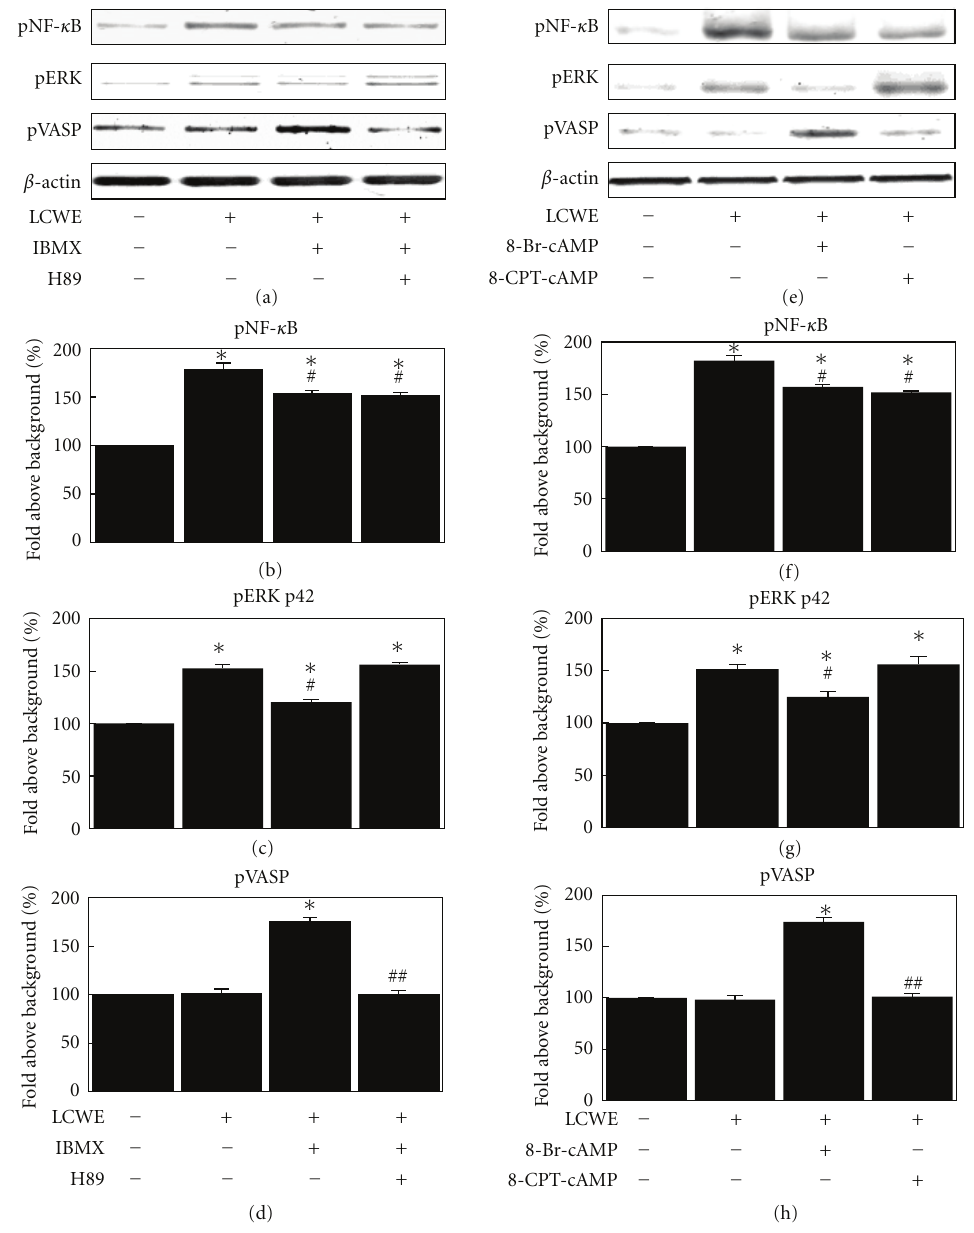
Figure 5: Change in the levels of phospho-NF- κ B (a, b), phospho-ERK (a, c), and phospho-VASP (a, d) in NIH3T3 mouse fibroblast cells after treatment with LCWE (10 μ g/mL), a combination of IBMX (1 μ M) and LCWE (10 μ g/mL), or a combination of IBMX (1 μ M), LCWE (10 μ g/mL), and H89 (5 μ M). Change in the levels of phospho-NF- κ B (e, f), phospho-ERK (e, g), and phospho-VASP (e, h) in NIH3T3 mouse fibroblast cells after treatment with LCWE (10 μ g/mL), a combination of 8-Br-cAMP (1mM) and LCWE (10 μ g/mL), or a combination of 8- CPT-cAMP (5 μ M) and LCWE (10 μ g/mL). Each column represents the mean ± SEM. ∗ P < 0 . 05 versus untreated controls. # P < 0 . 05 versus LCWE treatment group. ## P < 0 . 01 versus LCWE and IBMX treatment